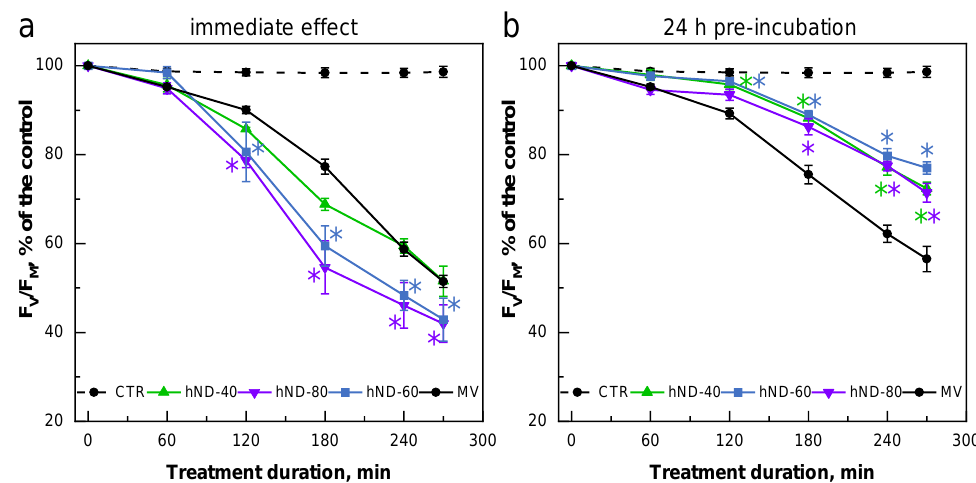
Figure 5. Changes in the F V /F M parameter induced by 3 μM MV in C. reinhardtii cultures supplemented with a high concentration of hNDs (40, 60 and 80 μg/mL). ( a ) “immediate effect”—MV and hNDs were added simultaneously to the cultures. ( b ) “24 h pre-incubation effect”—MV was added to the cultures pre-incubated for 24 h with hNDs. Values are expressed as a % of the control, F V /F M (T0) = 0.73 ± 0.008 ( a ) and F V /F M (T0) = 0.73 ± 0.004 ( b ). Asterisks indicate statistically significant differences between the MV and hND samples at corresponding time points, p < 0.05. Means of 2–3 independent experiments with 3 biological replicates (±SE, n = 6–9).